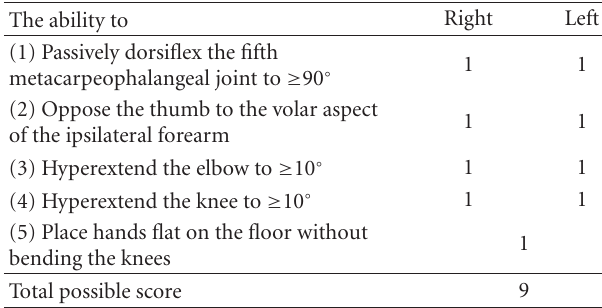
Table 1: Beighton’s joint hypermobility score. Table 2: Brighton’s diagnostic criteria for hypermobility syndrome. Major